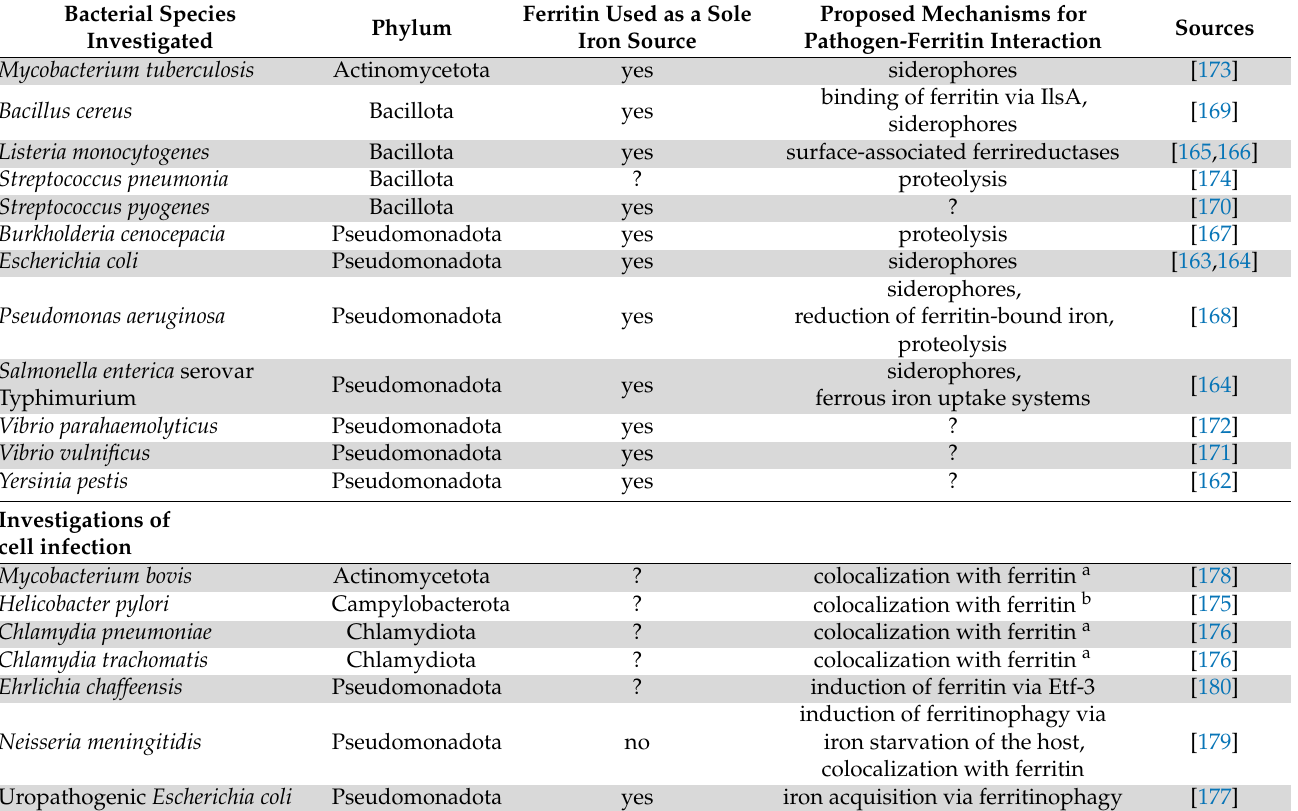
Table 1. List of investigated pathogens and the proposed mechanisms involved in pathogen–ferritin interaction. Question marks indicate that the mechanism has not been investigated in this species. However, it is to mention that specific mechanisms likely also work in other species which possess the same mechanism, e.g., same siderophore. a: assessed by fluorescence imaging; b: assessed by sucrose density gradient